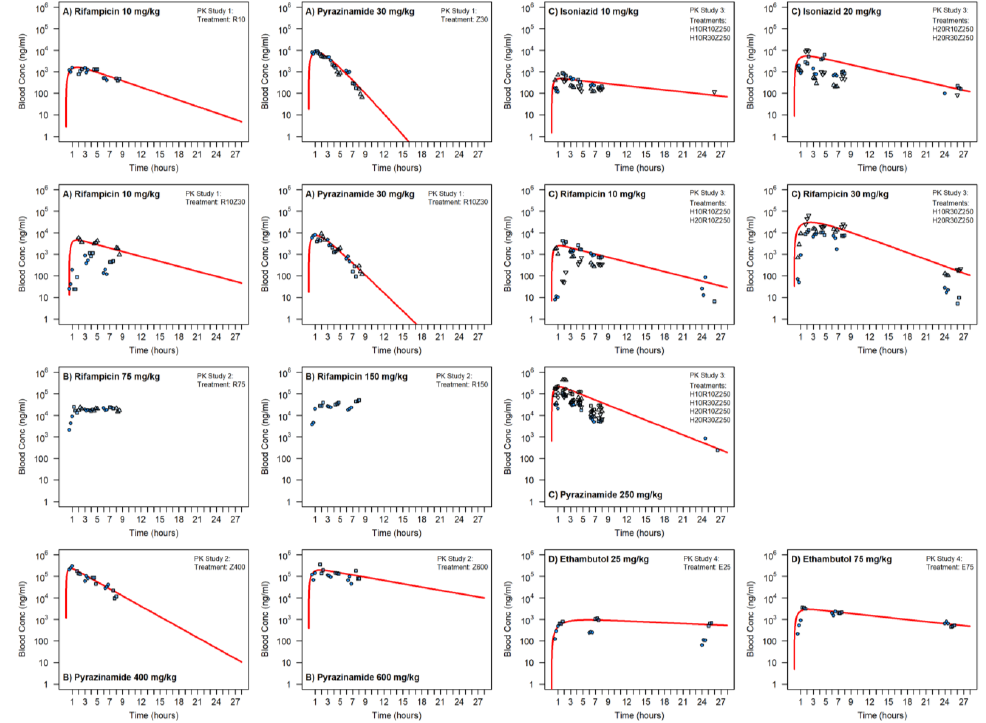
Figure 2. Blood PK of Rifampicin, Pyrazinamide Isoniazid and Ethambutol in cynomolgus macaques. Separate symbols for each individual subject, 1-compartment PK modeled fittings to naïve-pooled raw data (where feasible) shown by red line to derive CL, V, ka and AUC. PK study 2 (Figure 2) sought to evaluate exposures at higher doses of 75 and 150 mg/kg Rifampicin and 400 and 600 mg/kg Pyrazinamide (dosed singly) to assess tolerance of higher doses, mitigate uncertainty in the changed dosing format and observe if closer exposures to those required in human for efficacy were achievable. Unfortunately, the higher dose Rifampicin profiles were different to that at 10 mg/kg with the elimination phase not characterized under the limited sampling scheme achievable. Mean Cmax at 75 and 150 mg/kg was 23,267 ng/mL and 38,700 ng/mL, respectively, which are nonlinear with respect to dose compared to Cmax seen at 10 mg/kg. It appears that at the higher doses, and possibly due to the different dosage form, saturation of Rifampicin absorption and prolonged slow release/absorption from a depot in the gut has occurred, leading to “flip - flop” pharmacokinetics combined with some potential saturation of clearance lead- ing to higher Cmax than expected. Pyrazinamide also showed potential saturation of both absorption and clearance at the higher doses and changed dose form, with AUC and Cmax of 850 mg.h/L and 23,9500 ng/mL, respectively, at 400 mg/kg dose, and 2060 mg.h/L and 249,500 ng/mL at 600 mg/kg. To confirm the optimal doses of Rifampicin and Pyrazinamide, a third study was conducted to test Rifampicin at 10 and 30 mg/kg to mitigate the risk of variability in its exposure and straddle the hypothesized optimum doses of 20 mg/kg and Pyrazinamide at 250 mg/kg that would achieve exposures known to be efficacious in human (Figure 2). Isoniazid was included in the combination treatment and a fourth block of sampling